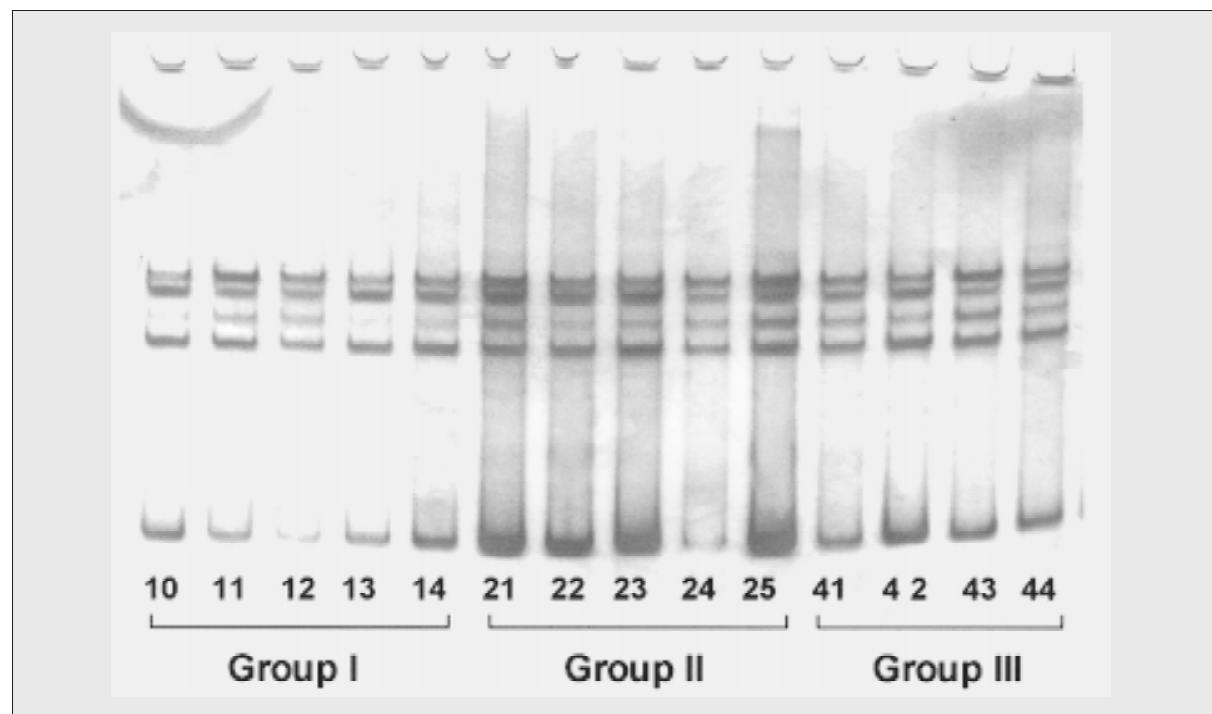
Figure 2 – PCR-SSCP showing no relevant alteration in a 7% polyacrylamide gel for exon 6 of tumor supressor gene TP53 in group I (control, n = 5), group II (initiated, n = 5) and group III (initiated + pb, n = 4)